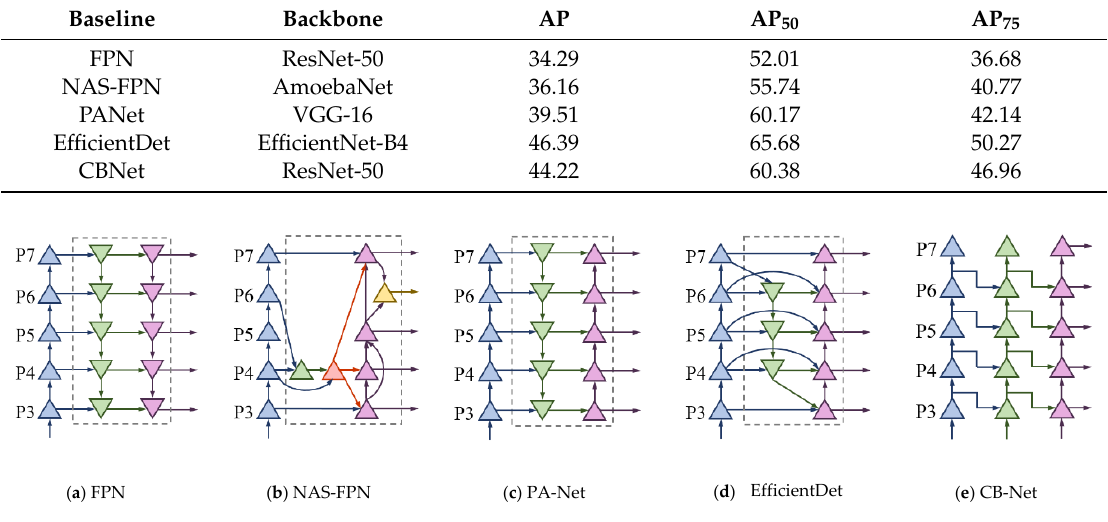
Figure 4. Feature pyramid network frameworks. Table 3. Performance of the state-of-the-art FPN baselines on FBDF.